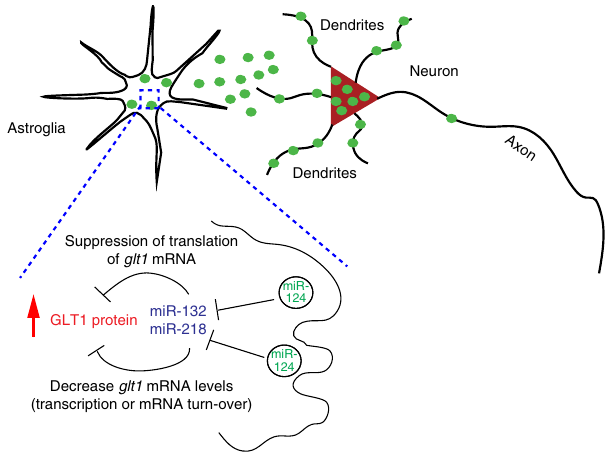
Fig. 10 Schematic diagram of exosomal miR-124-3p in neuron to astroglial communication. Green solid circles: neuron-secreted exosomes; In this model, miR-124-3p-containing neuronal exosomes are released somatodendritically and can be internalized into astrocytes to increase GLT1 protein by genetically suppressing downstream